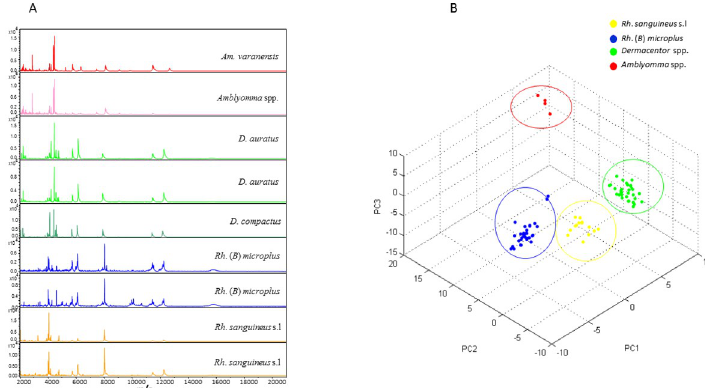
Fig 2. Comparison of MALDI-TOF MS spectra from the legs of six tick species collected in Vietnam. The MS spectra revealed intra-species reproducibility and inter-species specificity (A); The MS spectra were compared by Principal Component Analysis (B); a.u., arbitrary units; m/z, mass-to-charge ratio.